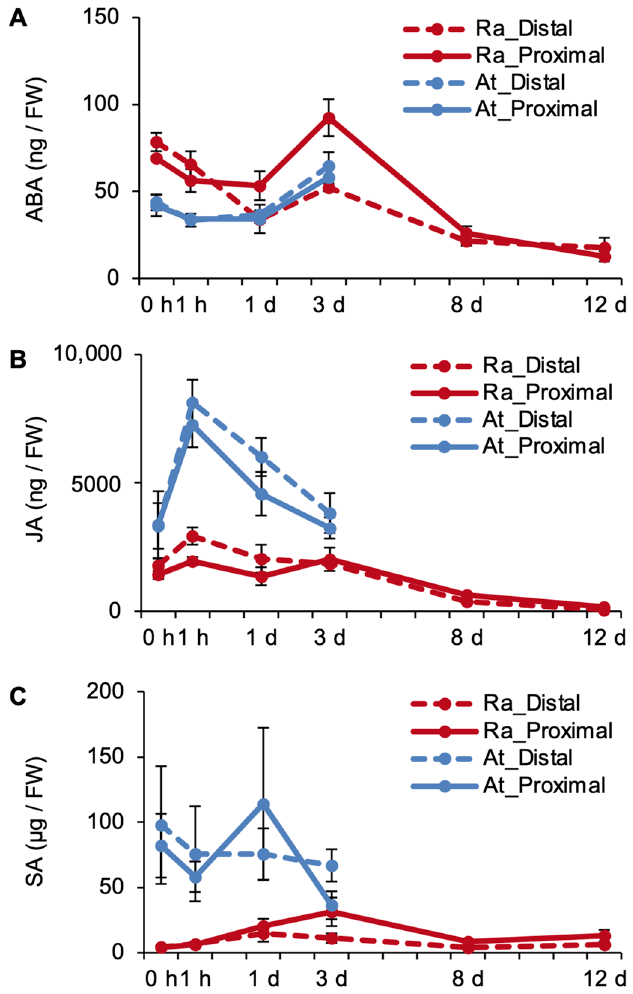
Figure 3. Time-course quantification of endogenous abscisic acid (ABA), jasmonic acid (JA), and salicylic acid (SA) in leaf fragments of R. aquatica and A. thaliana . ( A ) Quantification of endogenous ABA. ( B ) Quantification of endogenous JA. ( C ) Quantification of endogenous SA. Leaf fragments of A. thaliana could only be analyzed only from day 0 to 3. Dotted and solid lines indicate the expression levels at the distal and proximal sides, respectively. The vertical line and horizonal line indicate the amount of phytohormone (FW; fresh weight), and time points, respectively. Data are presented as mean ± SE ( n = 5).